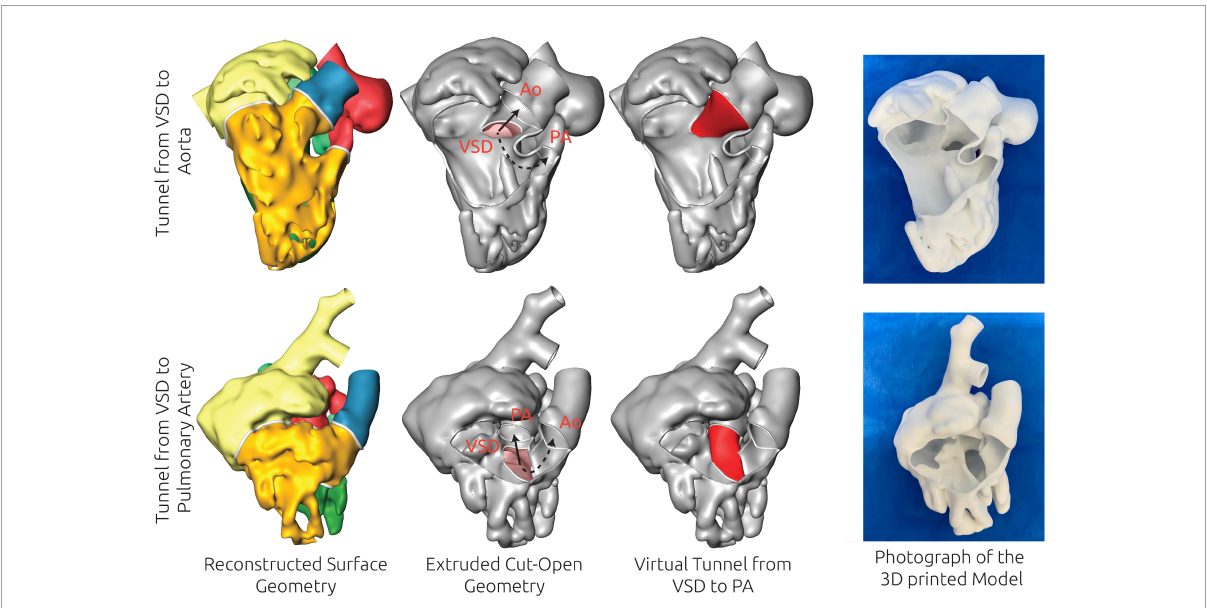
FIGURE4 Examples of the virtual treatment decision based on the 3D reconstructions for two patients (patient #7 and patient #8), for which biventricular repair (BVR) was feasible. The 3D reconstruction of the blood pool is shown in the left column, whereas the extruded, thin-walled geometry, superimposed with the relevant structures for treatment planning is shown in the second column. The virtual treatment strategy is shown in the third column, whereas the right column shows a photograph of a 3D print of the model. For patient #8 (upper row) BVR by creation of a tunnel from the ventricular septal defect (VSD) to the aorta (Ao) was considered feasible due to the size and orientation of these structures as well as the size of the left ventricle. In patient #7 the tunnel from VSD to Ao was considered to be too strongly bent and not feasible due to the orientation and shape of the VSD, whereas a connection from VSD to the pulmonary artery (PA) was considered feasible.